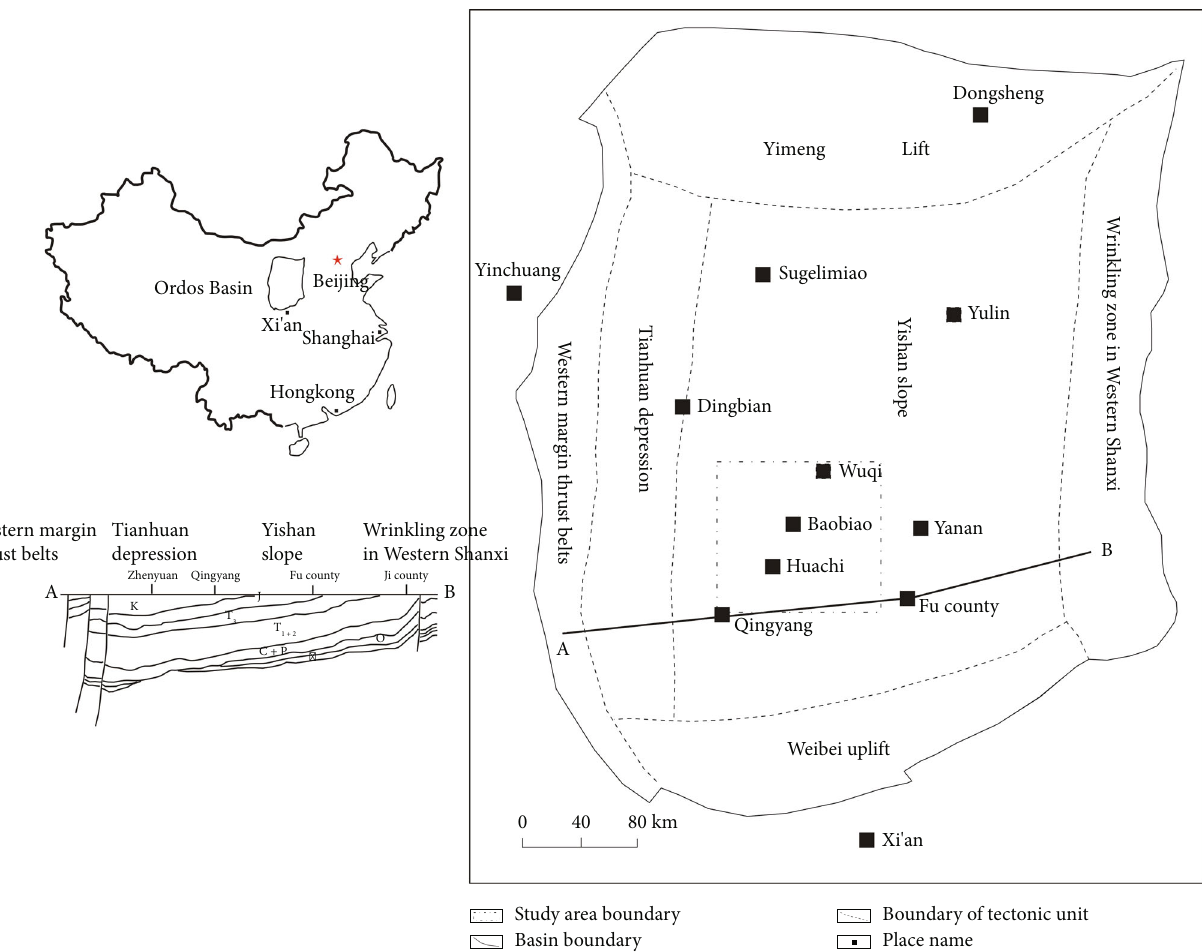
Figure 1: Regional structural location map in the study area (modi fi ed from Changqing Oil